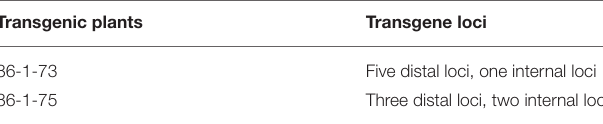
TABLE 1 | The locus number for the two transgenic plants, 86-1-73 and 86-1-75. Transgenic